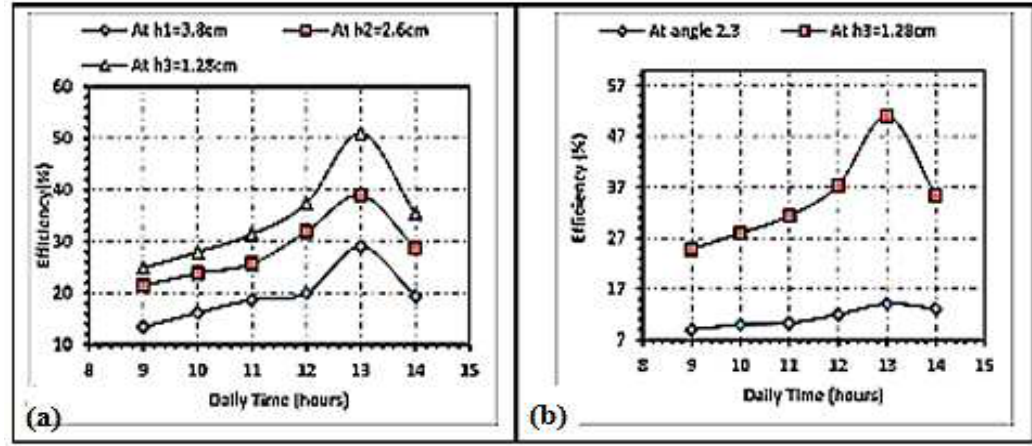
Fig. 12. Variation efficiency versus time(a) with reduction area. (b) with and without reduction